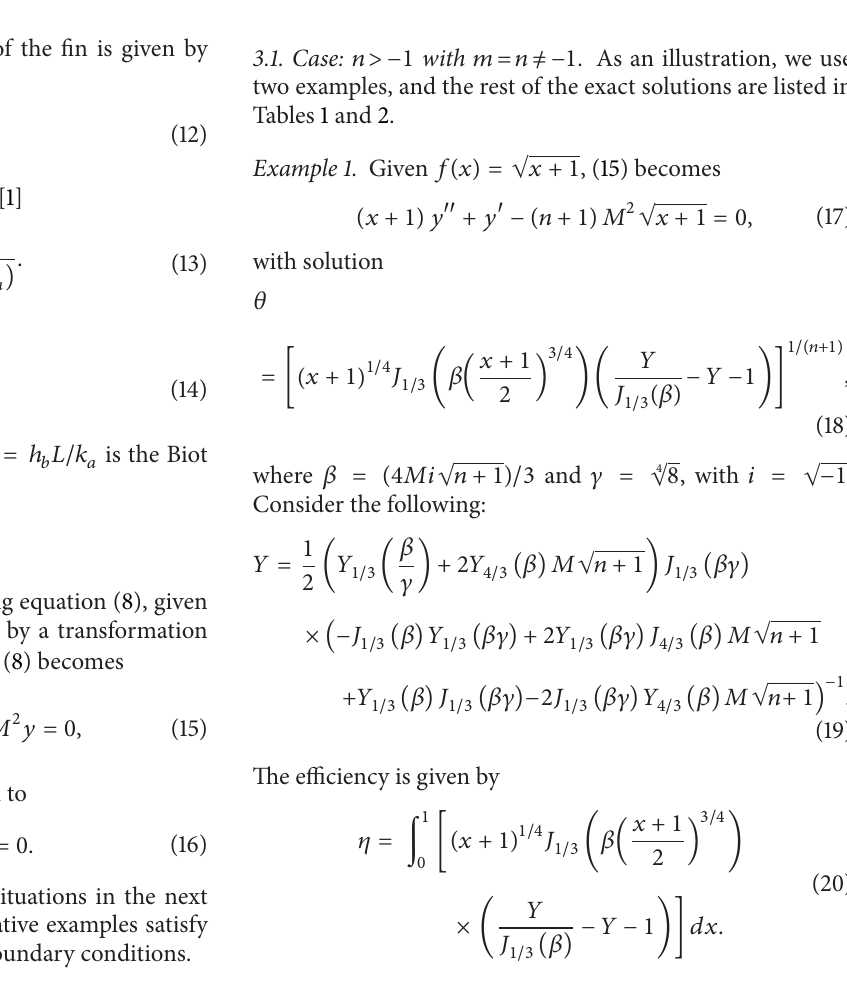
Figure 2: Temperature distribution for the profile 𝑓(𝑥) = √𝑥 + 1 given in (18) in a fin with varying values of 𝑀